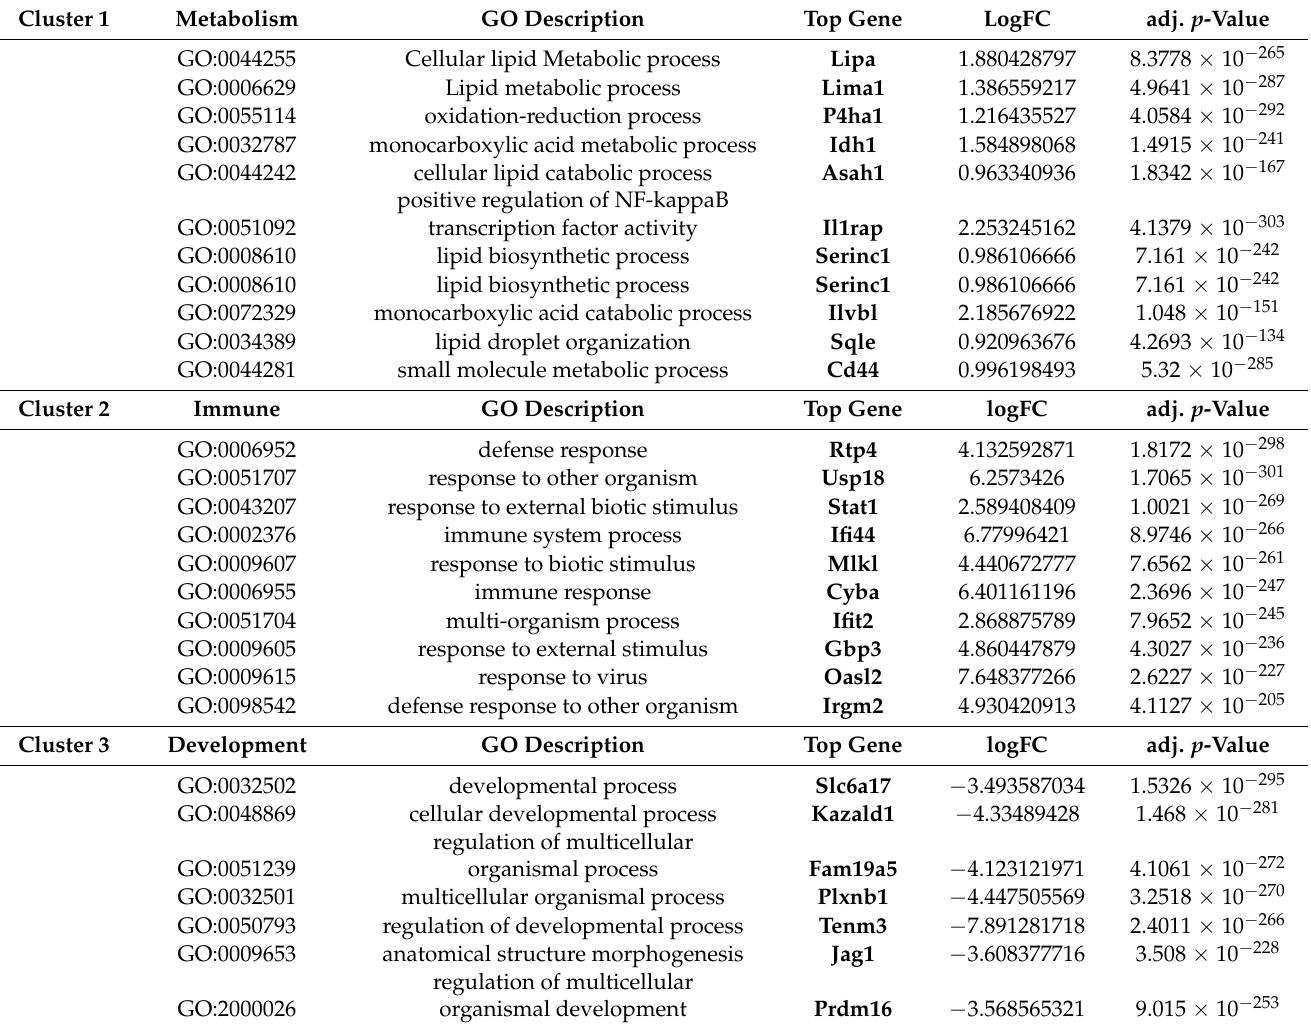
Table 1. Top 10 genes/GO terms in each